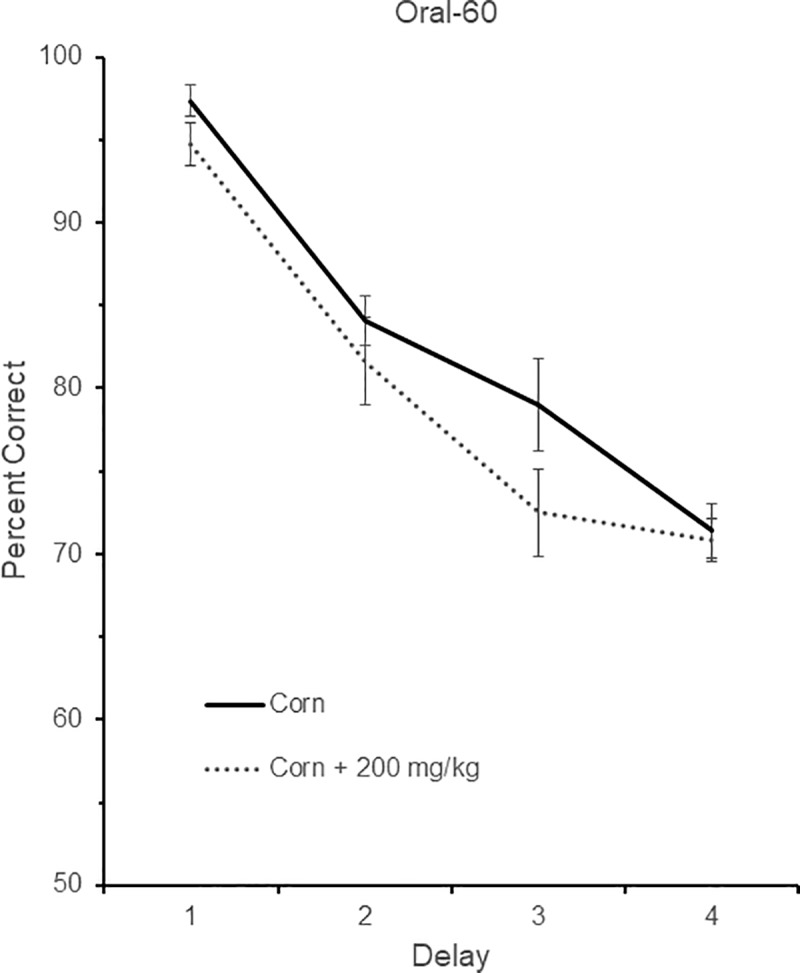
DMS performance in the Oral-60 condition.DMS performance following no drug (corn) or drug (corn + 200 mg/kg aniracetam in the Oral-60 condition. A total of five birds were tested. One bird was tested on delays of 0, 1, 2, and 4 sec (Delay set 1), two were tested on delays of 0, 2, 4, and 8 sec (Delay set 2), and two were tested with delays of 0, 3, 6, and 12 sec (Delay set 3). Chance is 50% correct. Error bars are +/- SEM.